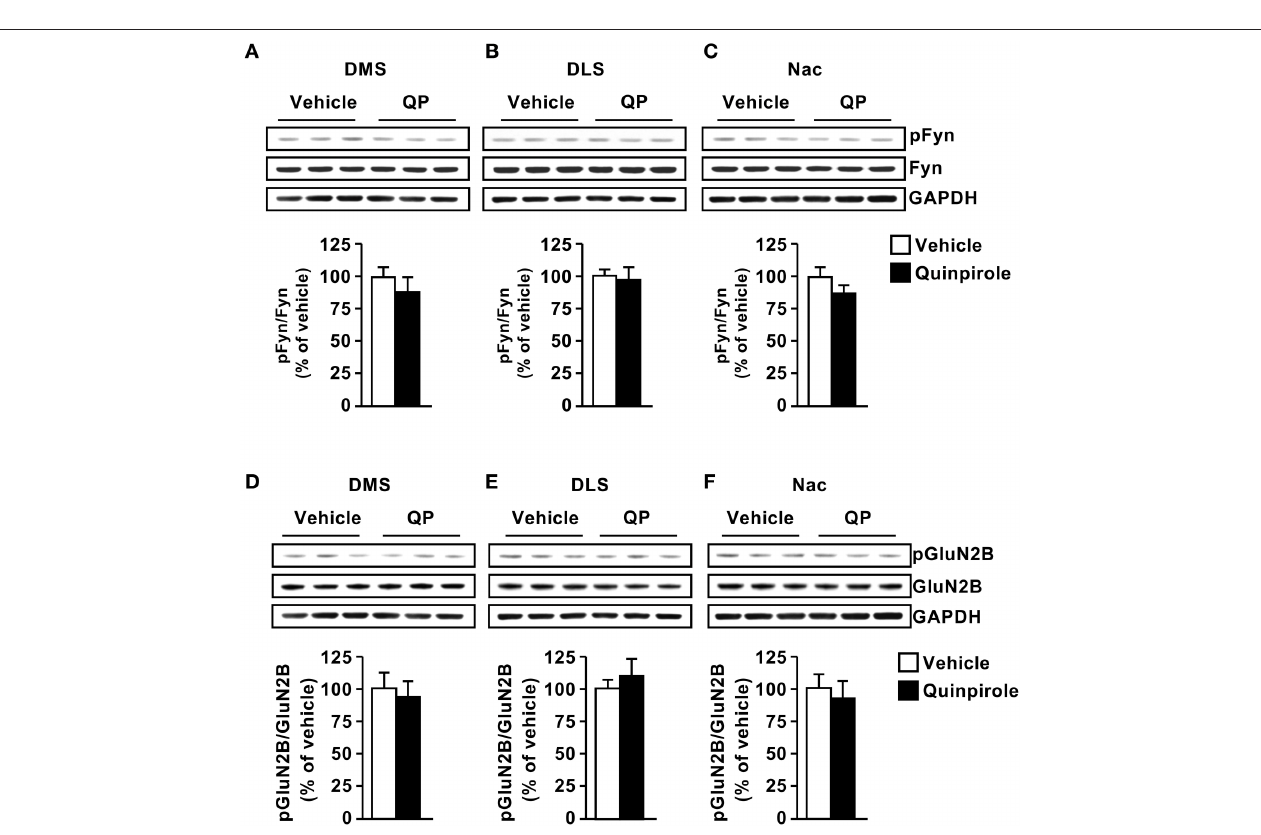
Frontiers in Molecular Neuroscience |